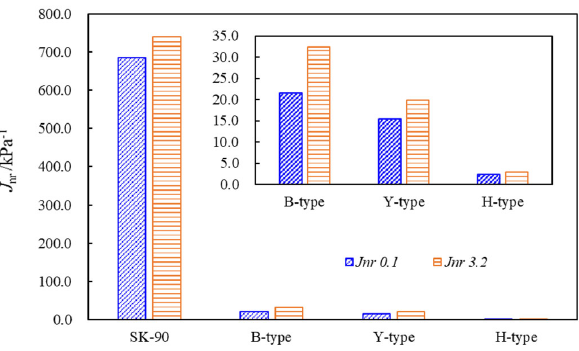
Figure 3. Unrecoverable creep compliance of di ff erent asphalt binders.